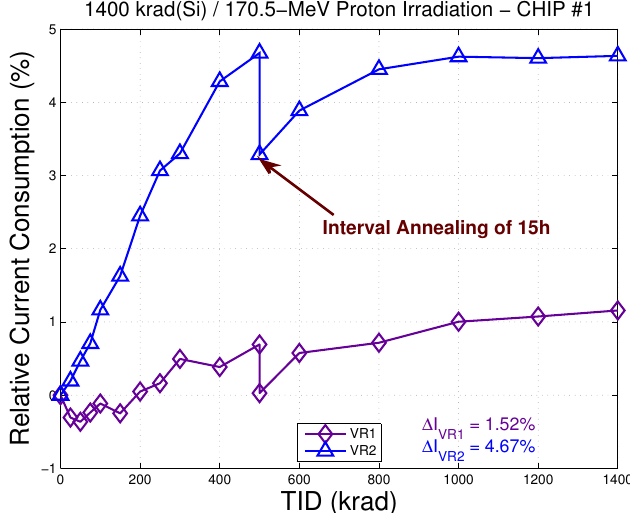
Figure 22. Relative change in current consumption (%) of the VR1 and VR2 when exposed to 170.5 MeV Proton irradiation, accumulating a total dose of 1400 krad(Si) with a fluence of 3.9 × 10 11 cm − 2 . An interval annealing step at room temperature was performed at 500